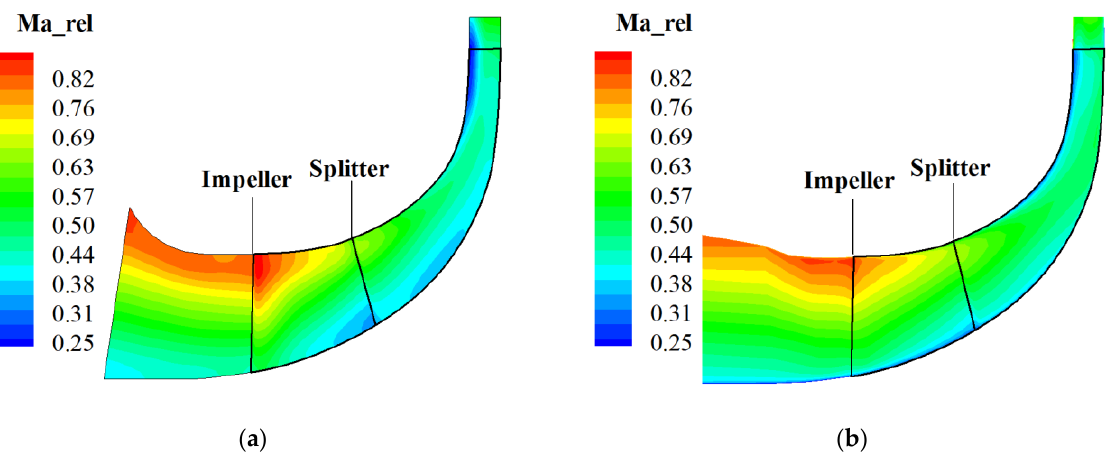
Figure 10. Relative Mach number of the HPCC at design mass flow rate. ( a ) Throughflow; ( b ) 3D CFD.